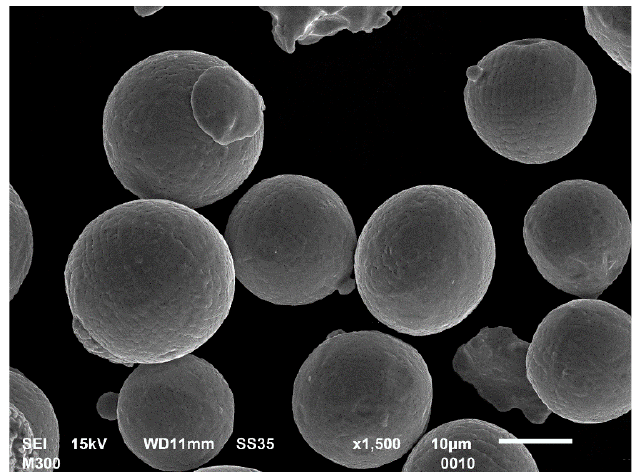
Figure 1. SEM image of M300 powder grains.